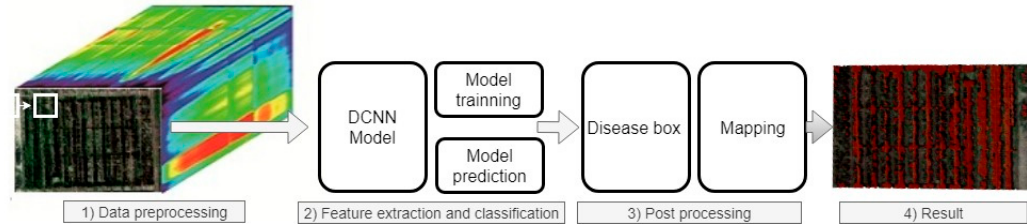
Figure 2. Schematic of identifying yellow rust areas in winter wheat fields with four steps: ( 1 ) Data preprocessing, ( 2 ) Feature extraction and classification, ( 3 ) Post processing and ( 4 ) Result output.